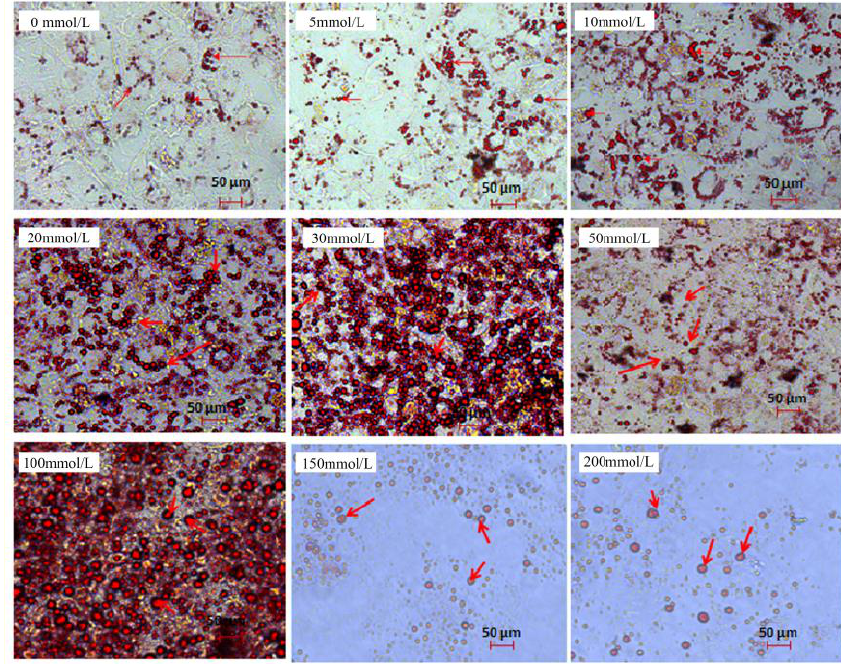
Figure 2. Lipid droplets were revealed by Oil red-O staining with different concentrations of glucose. Red arrows indicate lipid droplets.